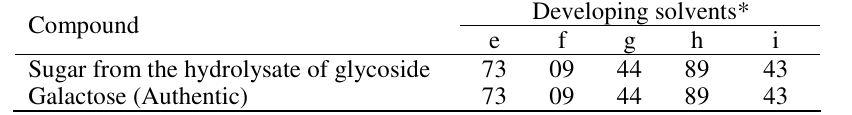
( x 100) values of the sugar from the glycoside of Thevetia peruviana f